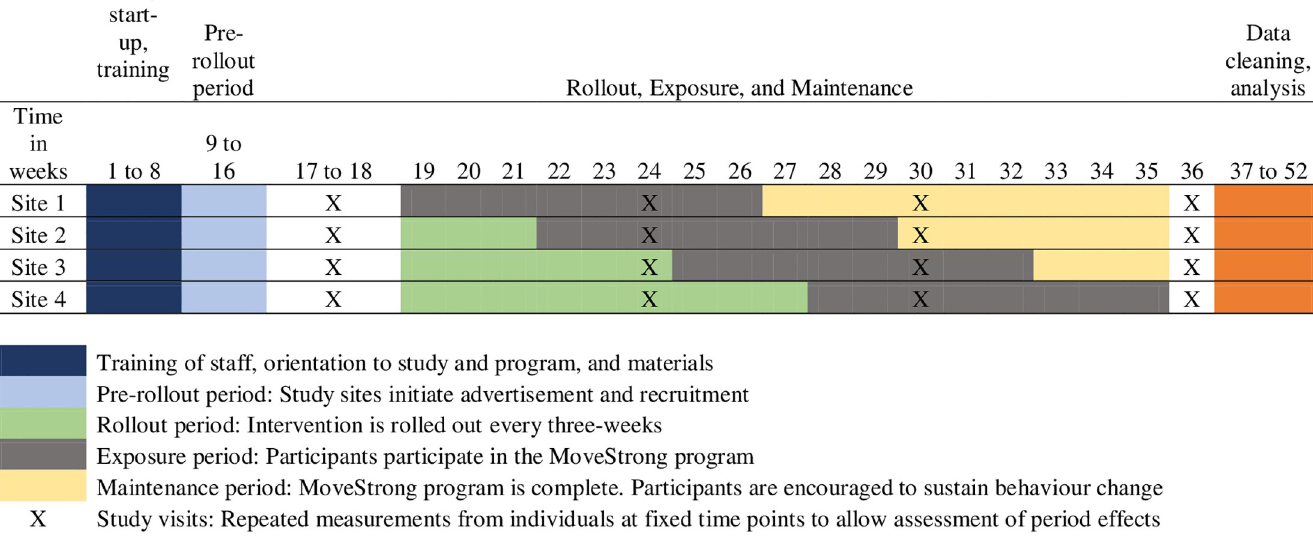
Fig 2. Timeline for the MoveStrong